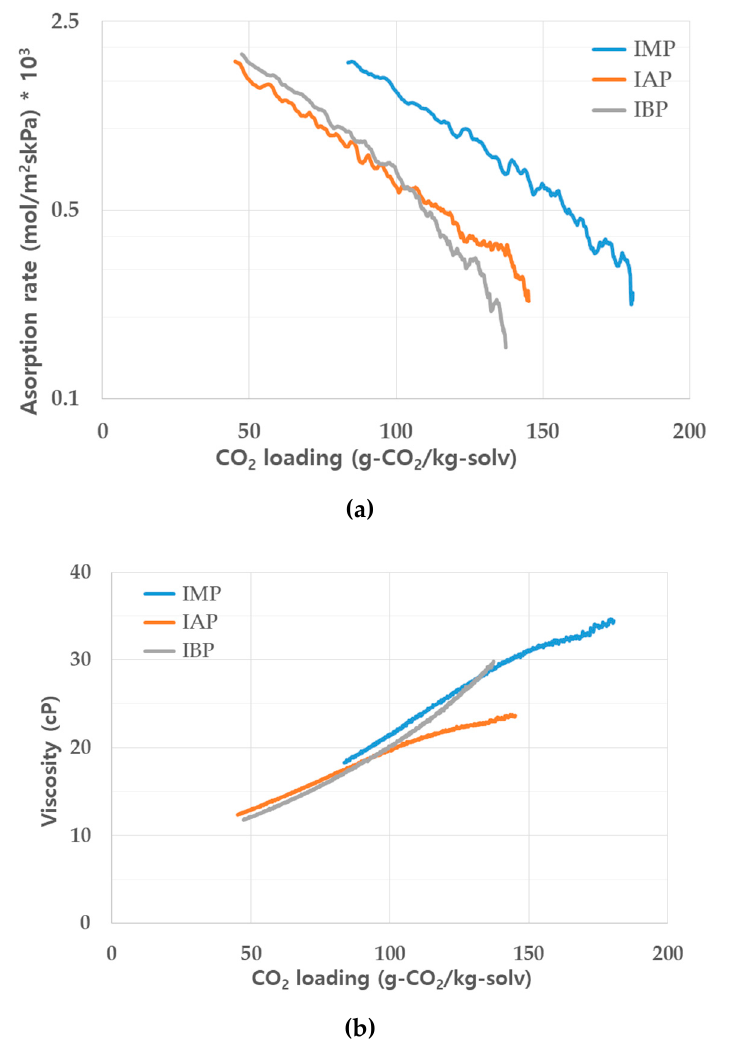
Figure 2. ( a ) The CO 2 absorption rate in terms of the overall mass transfer coe ffi cient. ( b ) Viscosity of the investigated amine blends.